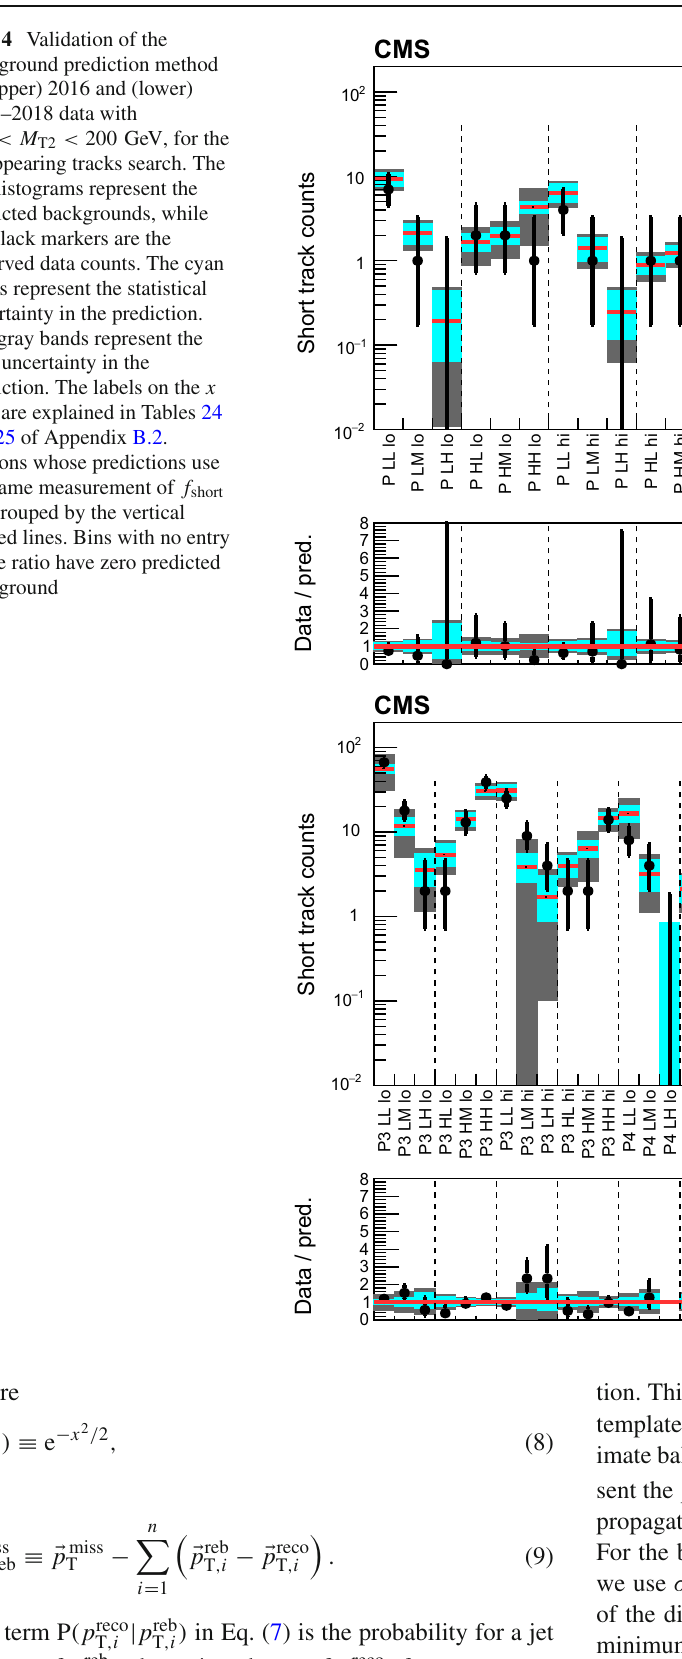
Fig. 4 Validation of the background prediction method in (upper) 2016 and (lower) 2017–2018 data with 100 < M T2 < 200 GeV, for the disappearing tracks search. The red histograms represent the predicted backgrounds, while the black markers are the observed data counts. The cyan bands represent the statistical uncertainty in the prediction. The gray bands represent the total uncertainty in the prediction. The labels on the x axes are explained in Tables 24 and 25 of Appendix B.2. Regions whose predictions use the same measurement of f short are grouped by the vertical dashed lines. Bins with no entry in the ratio have zero predicted background